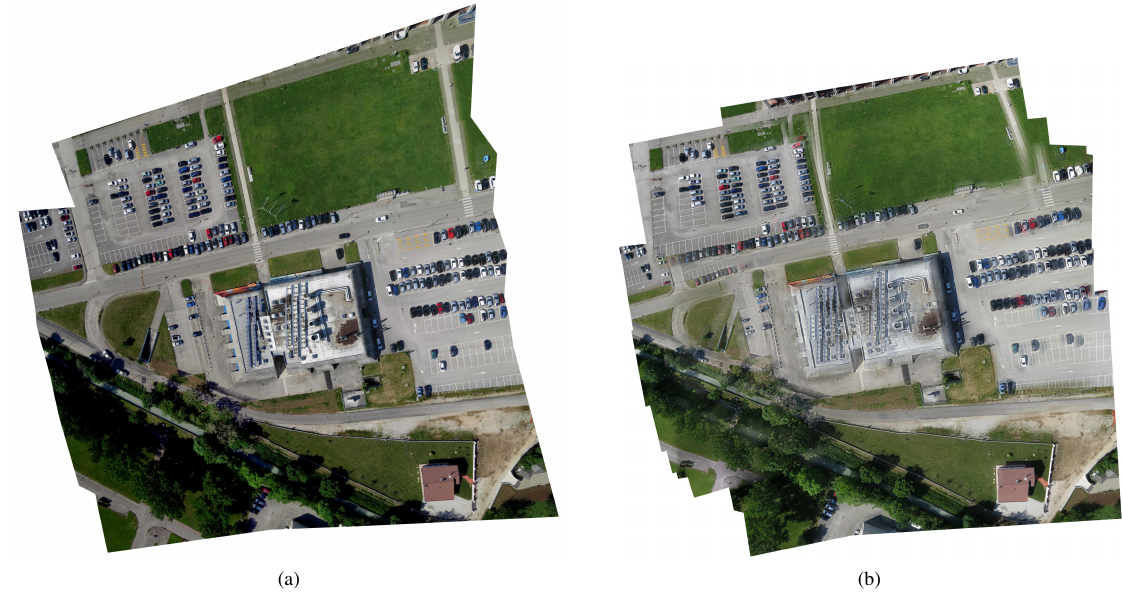
Figure 10. Dataset 2. (a) Mosaic obtained with the proposed method. (b) Mosaic obtained with AutoStitch